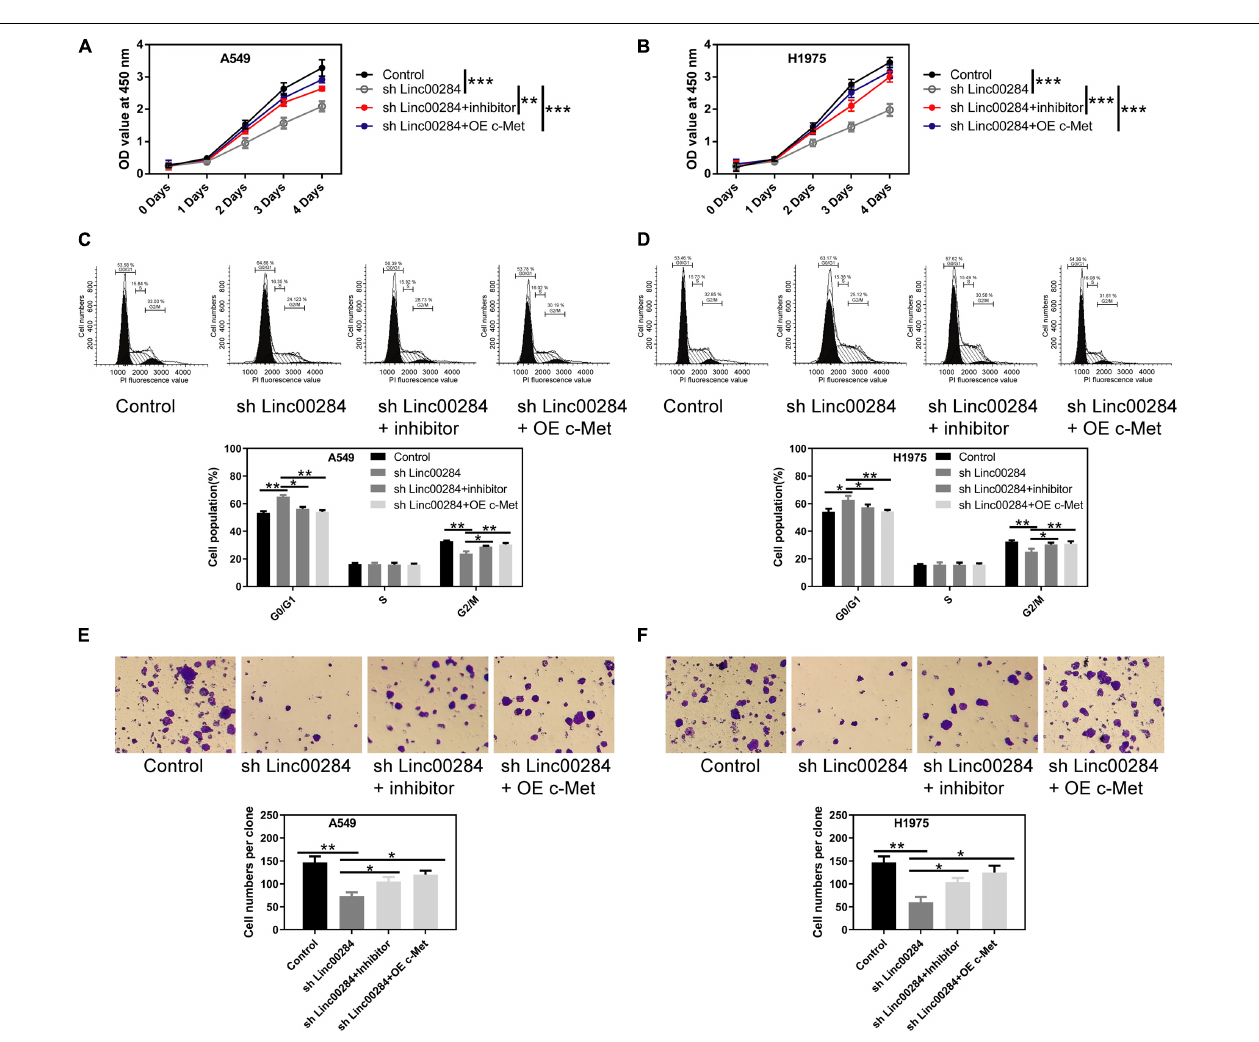
FIGURE 6 | Linc00284/miR-205-3p/c-Met axis regulates lung cancer cell proliferation. (A,B) Cell viability of (A) A549 and (B) H1975 cells in which Linc00284 was knocked down with miR-205-3p silencing or c-Met overexpression as assessed by CCK-8 assay. (C,D) Representative images and statistical results of cell cycle distribution in (C) A549 and (D) H1975 cells in which Linc00284 was knocked down with miR-205-3p silencing or c-Met overexpression. (E,F) Representative images and quantification of the colony-forming abilities of (E) A549 and (F) H1975 cells in which Linc00284 was knocked down with miR-205-3p silencing or c-Met overexpression. Magnification, × 10. Data are expressed as the means ± SD of triplicate independent experiments. Multiple comparisons were analyzed using one-way ANOVA followed by Tukey’s test. * P < 0.05, ** P < 0.01, and *** P < 0.001, compared with the matched control cells.